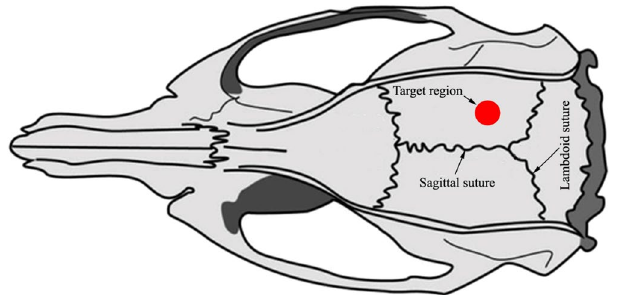
Figure 7. Anatomical mapping and target area for rod impact. The blow was dealt to the right hemisphere 2 mm lateral from the midline and 4 mm forth from the lambdoid suture. The red dot indicates the place